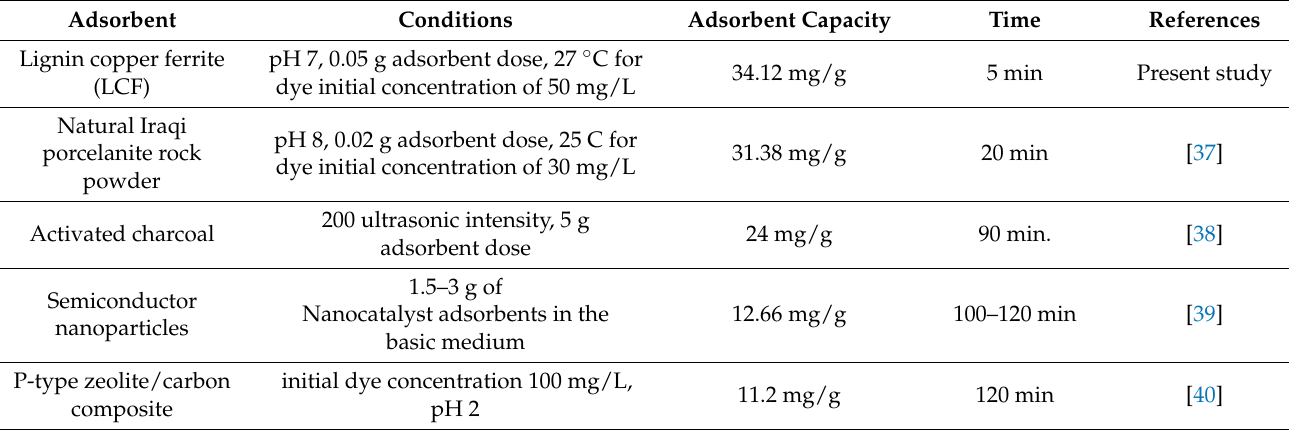
Table 5. Comparison between LCF capacity and other adsorbents used for CV removal.